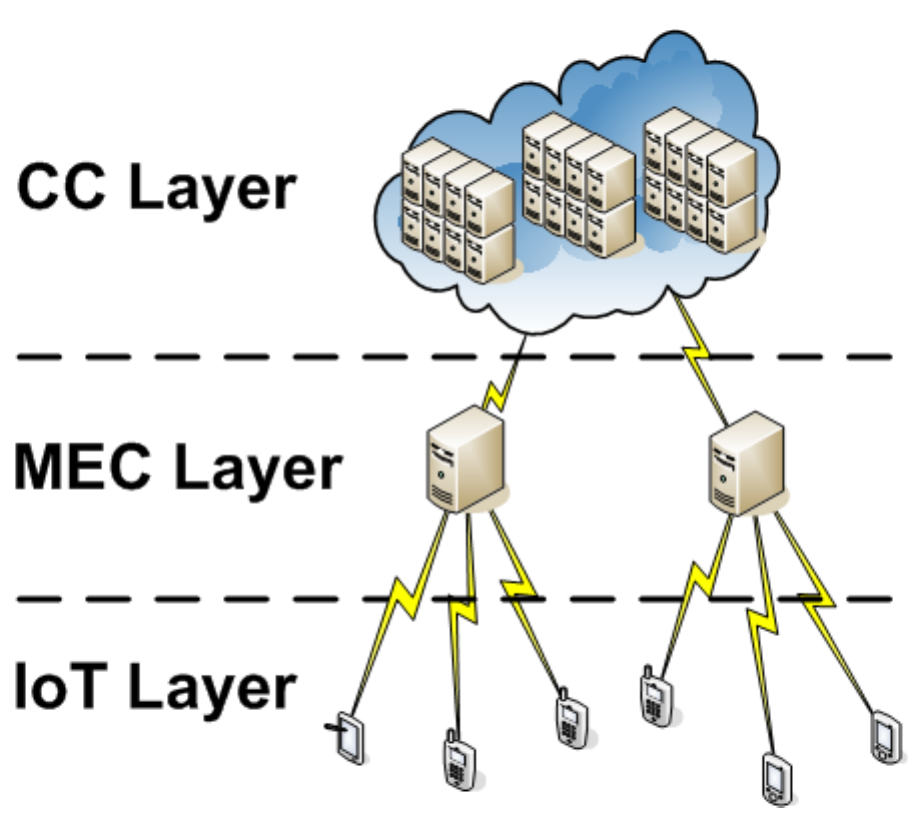
Figure 1. System